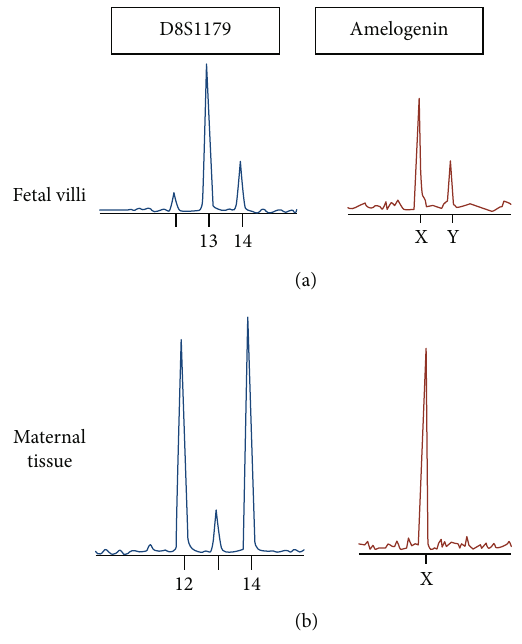
Figure 3: Genetic pro fi les of a dispermic partial hydatidiform mole by multiplex PCR assay. Dispermic paternal alleles (with homozygous paternal alleles in duplicate quantity in D8S1179 locus) shown, in addition to the presence of one maternal allele. Normal biallelic pro fi les seen in the (b) maternal